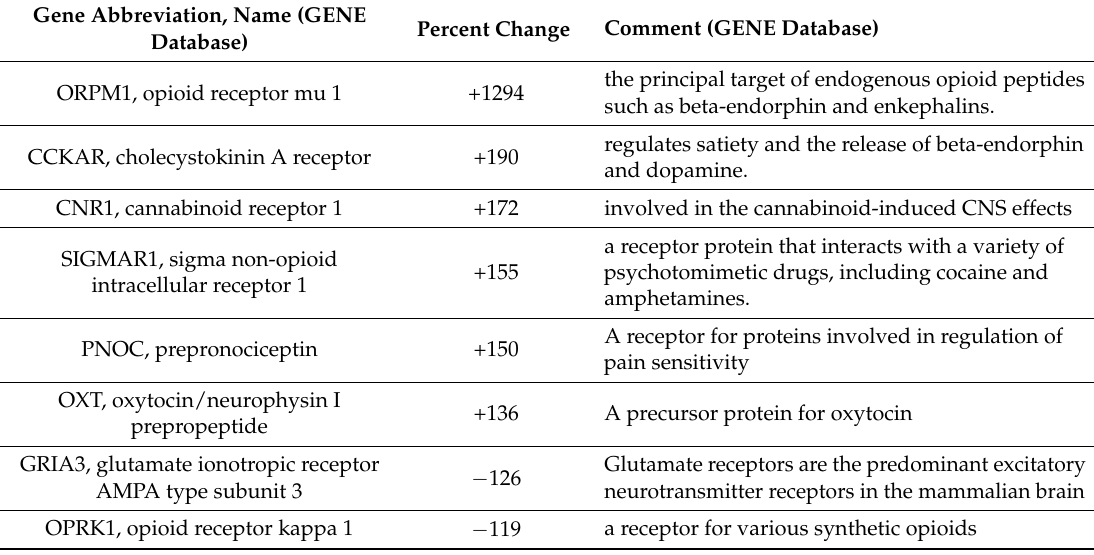
Table 4. GHK and Genes Associated with Pain